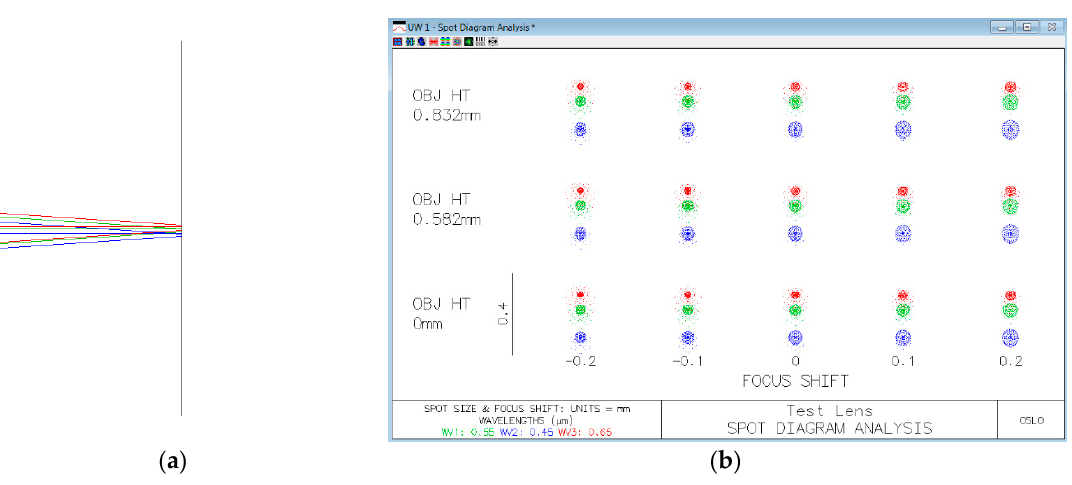
Figure 6. Focus condition of the dual-prism CASSI at the image plane: ( a ) ray diagram for the 450, 550, and 650 nm presented in blue, green, and red colored rays respectively; ( b ) the spot diagram of 450, 550, and 650 nm rays at three different field points and five focus shifts with respect to the focal point.